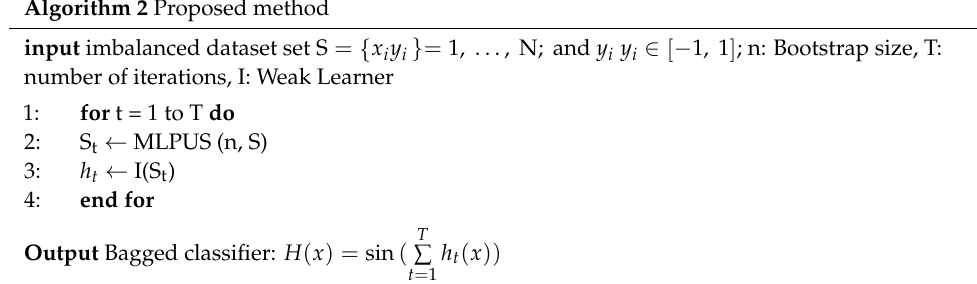
Algorithm 2 Proposed